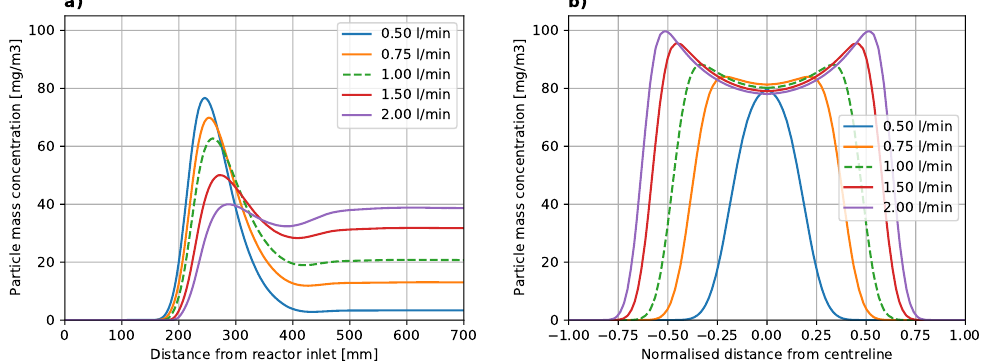
Figure 8. Plots of the dimensional catalyst particle mass concentration: ( a ) over the length of the reactor; and ( b ) as a radial slice 500mm downstream of the reactor. Each line corresponds to a different